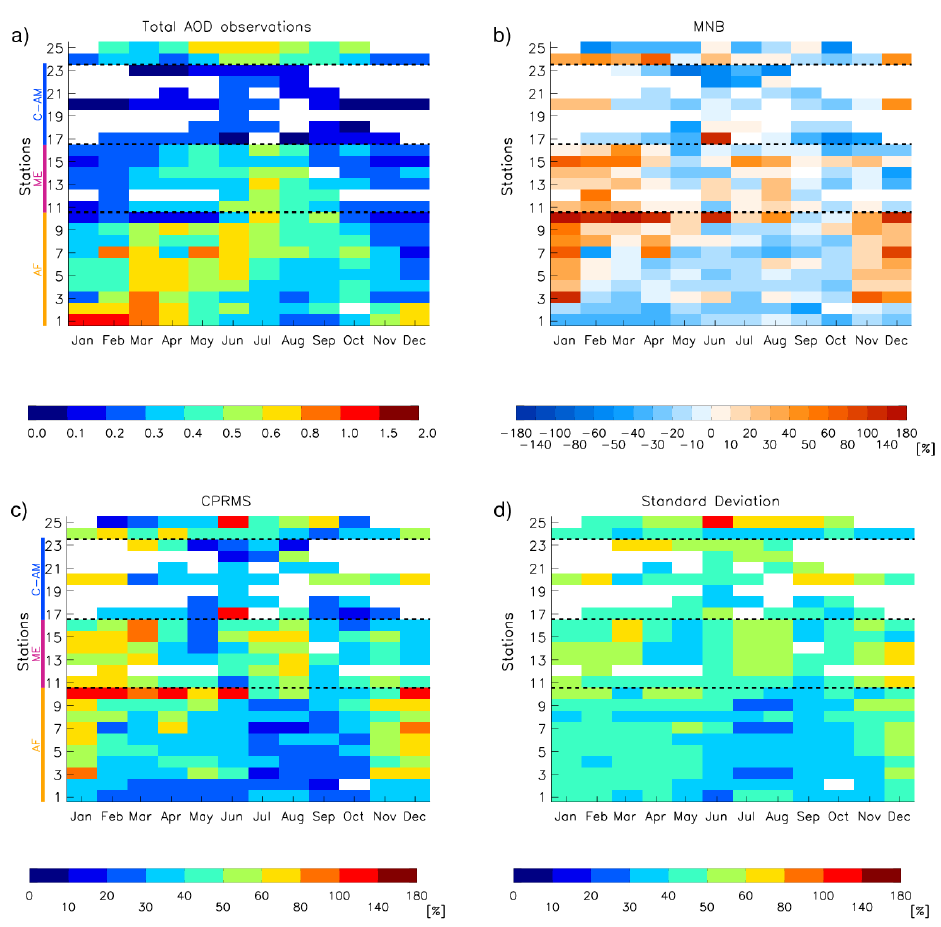
Fig. 10. AERONET AOD at 550nm is shown together with the mean normalized bias (MNB), the normalized centred pattern root mean square error (CPRMS) and the normalized standard deviation (Sect. 2.4). In all sub-figures, each row corresponds to the seasonal cycle at one AERONET station. They have been grouped into African (AF, orange), Middle East (ME, violet) and Caribbean-American (C-AM, blue) stations and stations elsewhere in the world (OT, black). Each one of these groups is identified by a coloured bar on the left side of the left hand figure. Stations are ordered from south to north within each group. The row for each station corresponds to the number presented in Fig. 8. Name and location of each station is given in Table S3 of the Supplement. White color corresponds to month without measurements or month not complying with the selection criteria (Sect. 2.3). AERONET data correspond to the climatology based on the multi-annual database 1996–2006. For the individual figure of each model presenting the simulated values and their differences (in %) with respect to observations see Figs. S4 and S5, respectively, in the